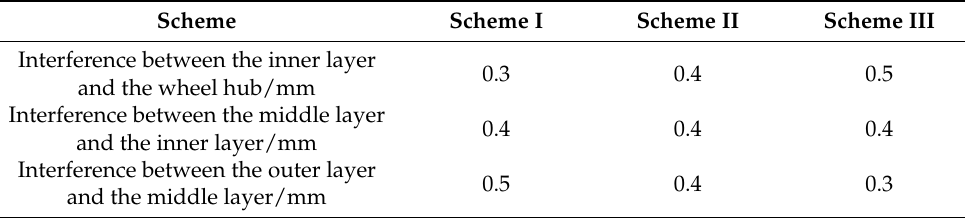
Table 4. Interference between contact